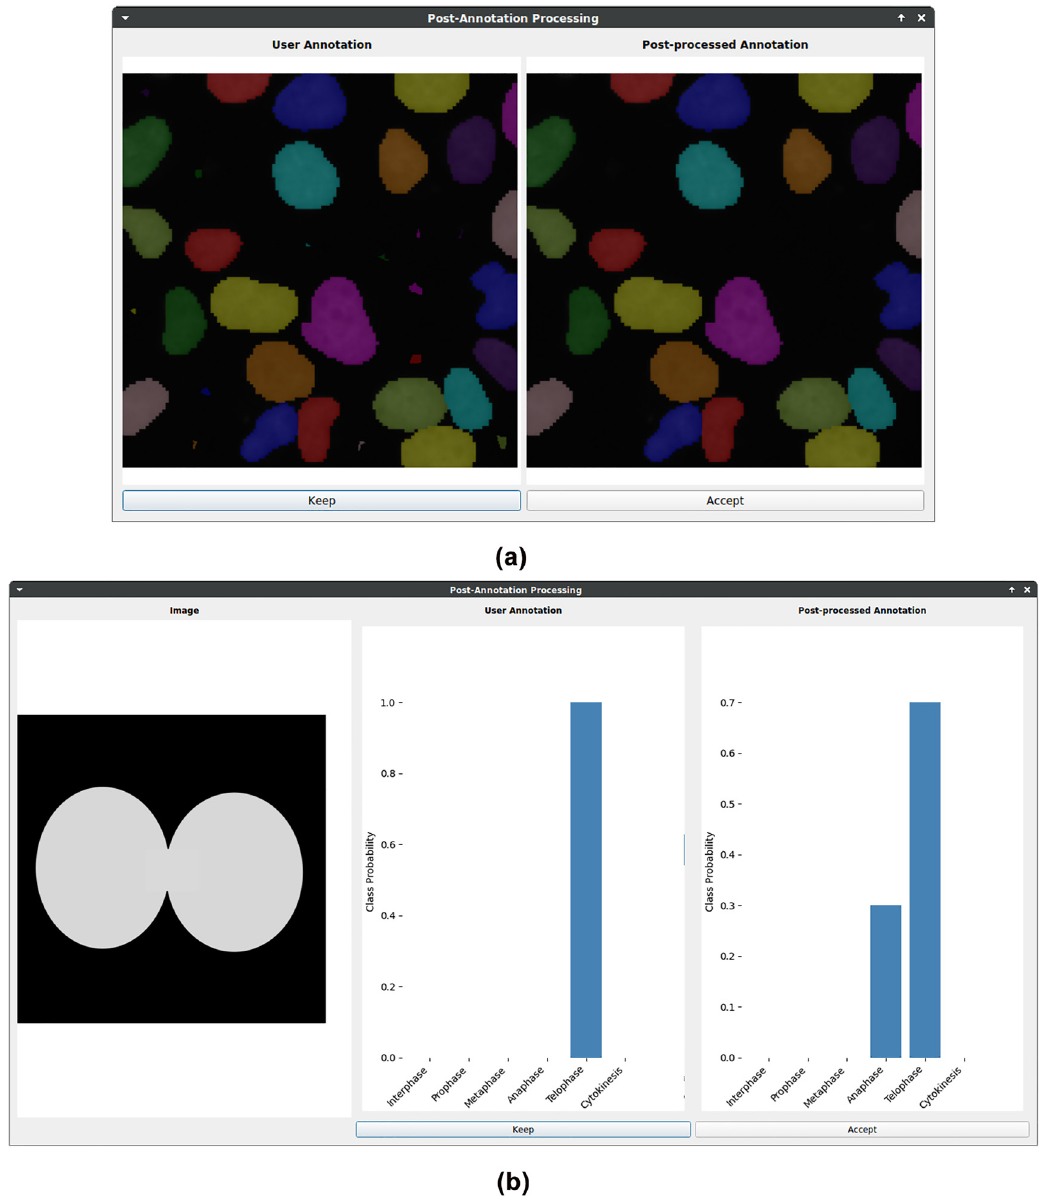
Figure 9: Illustration of methods in post-annotation-processing. Exemplary results of post-annotation processing. (a) Instance Segmentation. The method of removing small objects is displayed. (b) Classification. The exemplary method for fuzzy annotation is shown for a synthetic image illustrating cell mitosis. The sharp label of telophase is transformed into a mixture of telophase and anaphase. Hence, fuzzy annotation can be used in ambiguous